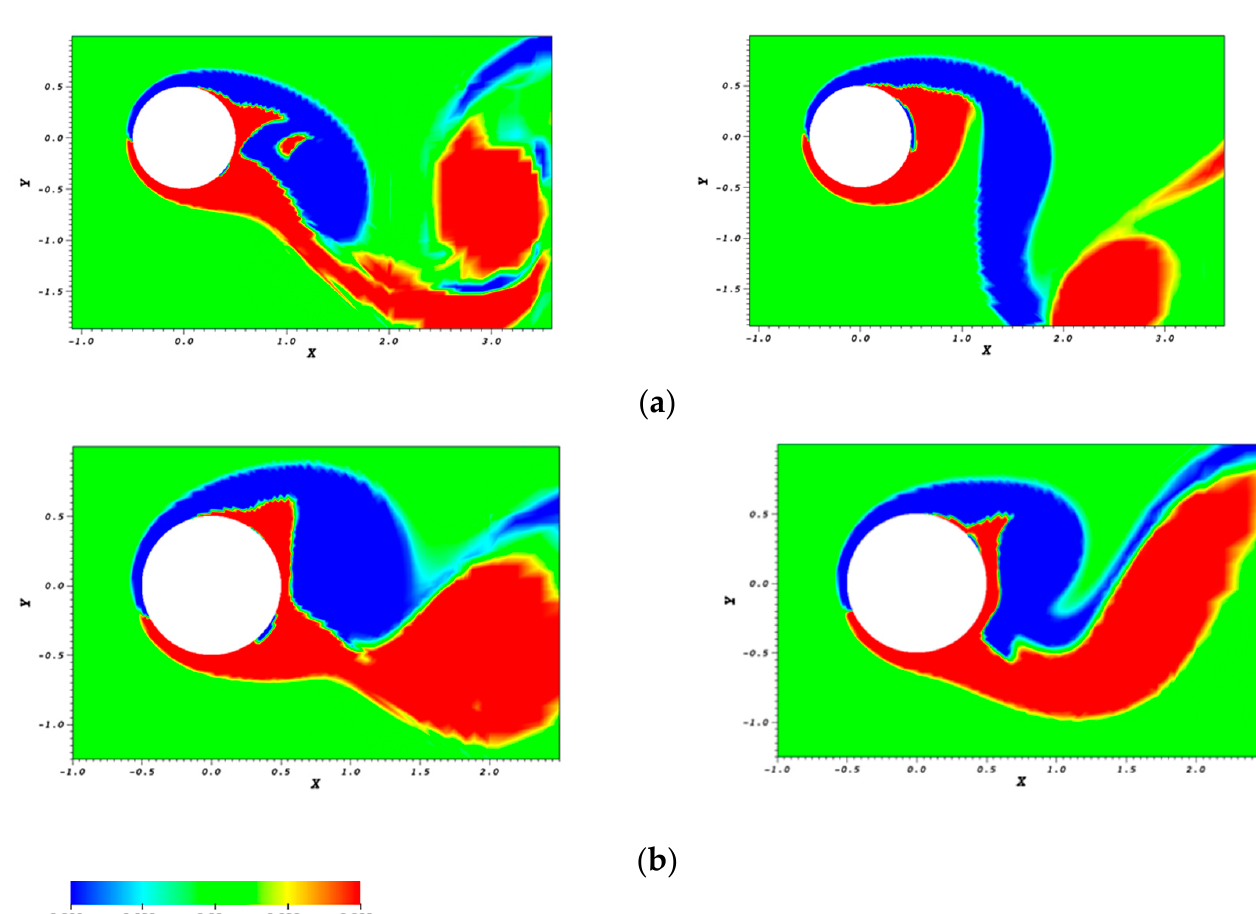
Figure 24. Instantaneous isocontours of spanwise vorticity for the plane z = 0, with the cylinder at its mean position ( η y /D = η x /D = 0): ( a ) F = 0.9, A y /D = 0.40, ( b ) F = 1.1, A y /D = 0.30. The left column corresponds to counter-clockwise cylinder oscillation, and the right column to clockwise oscillation.